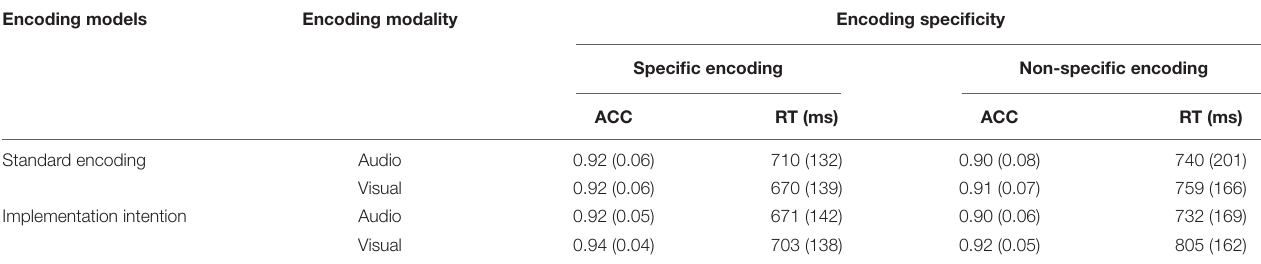
TABLE 3 | The performance of ongoing tasks in different conditions M (SD)